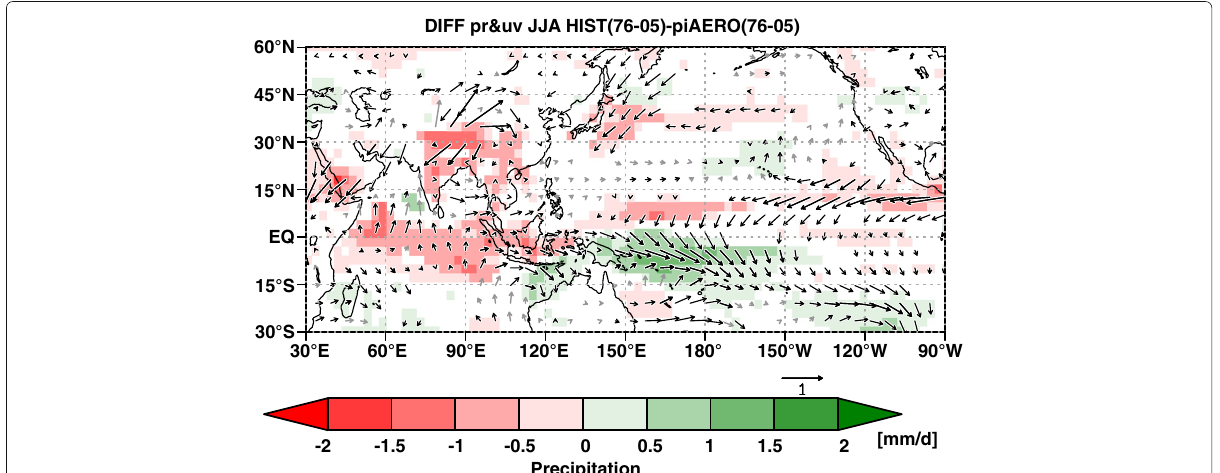
Fig. 6 As in Fig. 3, but for precipitation (color) and 10 m surface horizontal winds (vector) during JJA. The unit of precipitation (wind) is mm day − 1 (m s − 1 ). Gray vectors represent the spatial pattern of differences in wind, which are not statistically significant. Only stronger differences (>0.2 m s − 1 ) are plotted